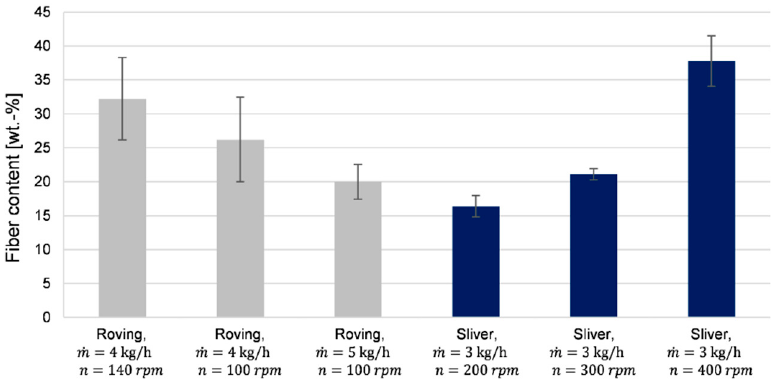
Figure 9. Fiber content in preliminary tests with carbon fiber roving and recycled staple fiber sliver.